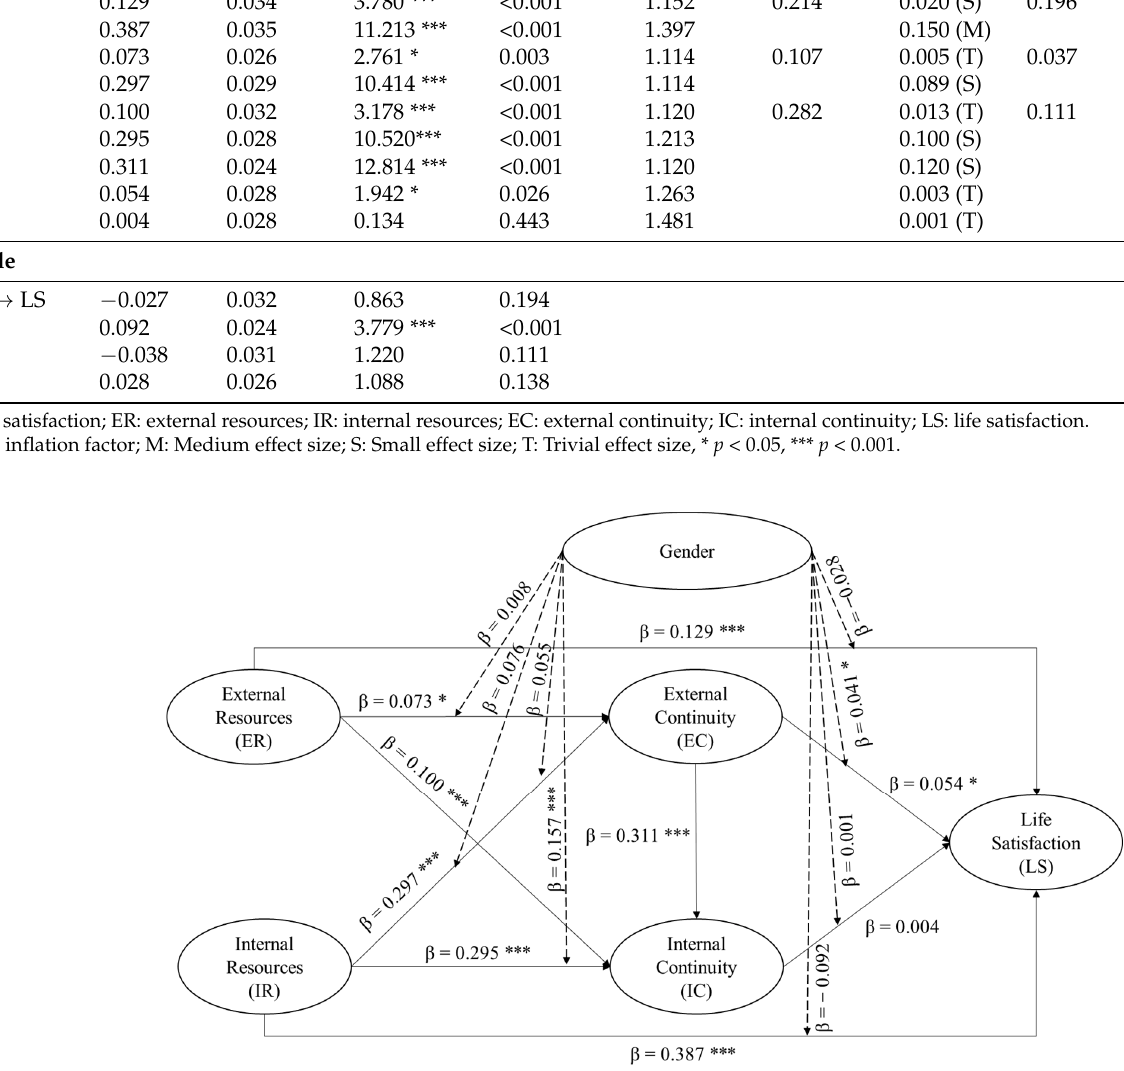
Figure 3. Structural equation model of resources, continuity and life satisfaction for older adults.